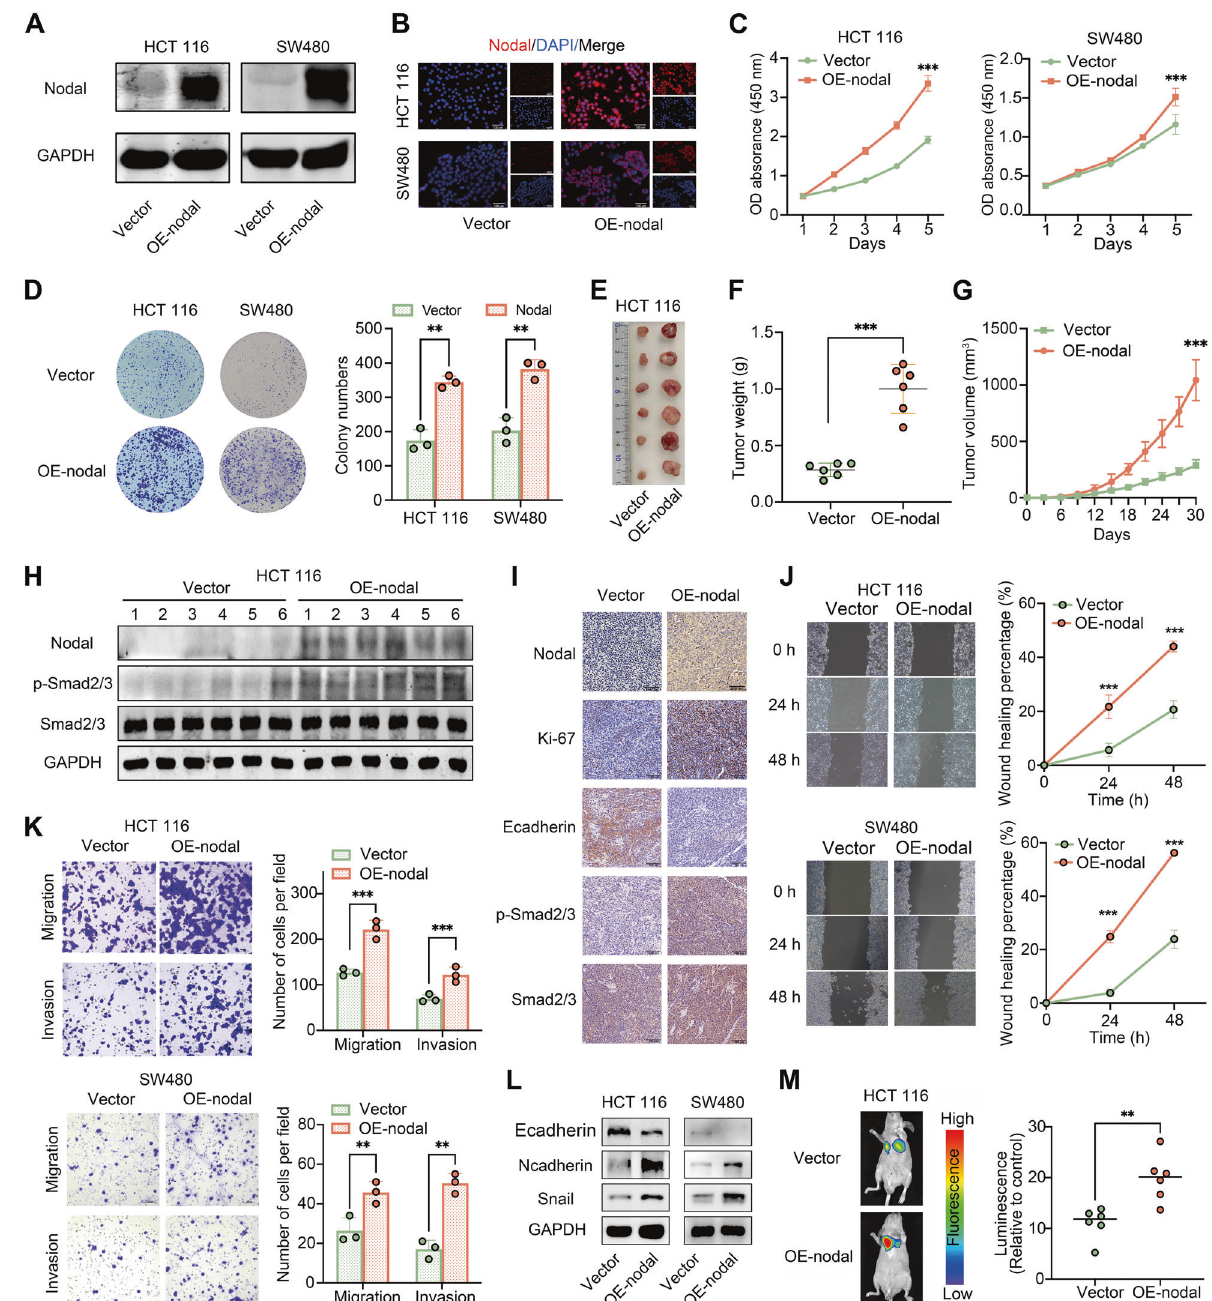
Fig. 2 Overexpression of Nodal promoted the proliferation, migration and invasion abilities of CRC cells in vitro and in vivo. A Western blotting was performed to examine the protein expression of Nodal in Nodal-overexpressing HCT116 cells and SW480 cells (vector group: cells transfected with an empty vector; oe-Nodal group: cells transfected with the Nodal lentiviral overexpression vector). B Representative images of Nodal expression detected in Nodal-overexpressing HCT116 cells and SW480 cells via IF staining. C , D CCK-8 and colony formation assays validated the increased proliferative ability of HCT116 and SW480 cells after Nodal overexpression. E Representative images for the xenograft tumours morphology. F , G The volume and weight of tumours were evaluated in two groups. H Western blotting was performed to examine the expression of Nodal, p-Smad2/3 and Smad2/3 in each xenograft tumor tissue. I The Nodal, Ki-67, E-cadherin, p-Smad2/3, and Smad2/3 expressions in xenograft tumour tissues were detected via IHC staining. J Wound healing assay revealed that Nodal overexpression increased the migration ability of HCT116 and SW480 cells. K Transwell assay validated the increased migration and invasion ability of HCT116 and SW480 cells after Nodal overexpression. L Western blotting was performed to examine the E-cadherin, N-cadherin and Snail expressions of HCT116 and SW480 cells in the vector/oe-Nodal group. M Representative fl uorescence images of lung metastasis in mice and the relative luminescence intensity. ( ∗∗ P < 0.01 and ∗∗∗ P <